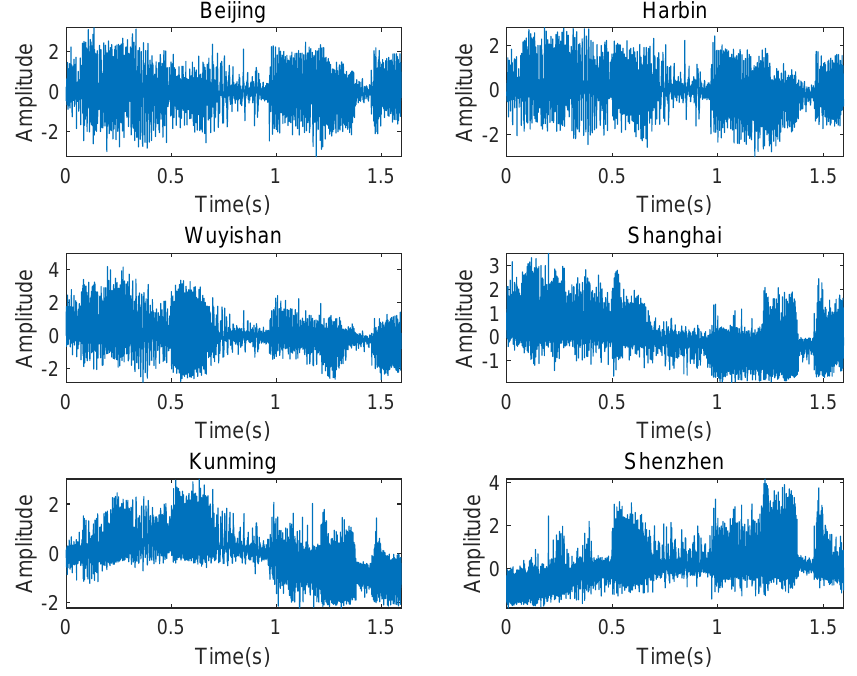
Figure 8. Received AM signals with the center frequency of 7.23